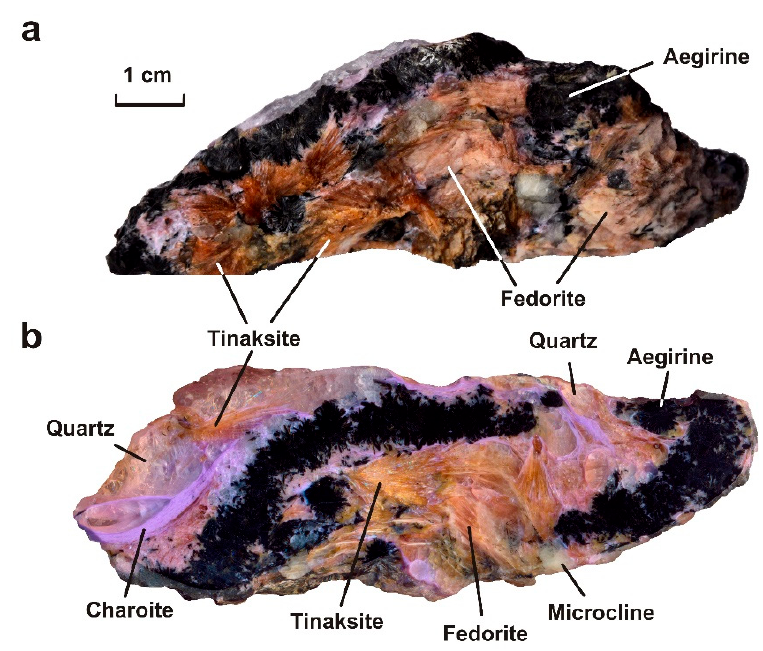
Figure 5. Sample Irk-53 with fedorite from the Irkutskiy district: ( a ) unpolished sample, ( b ) polished sample.